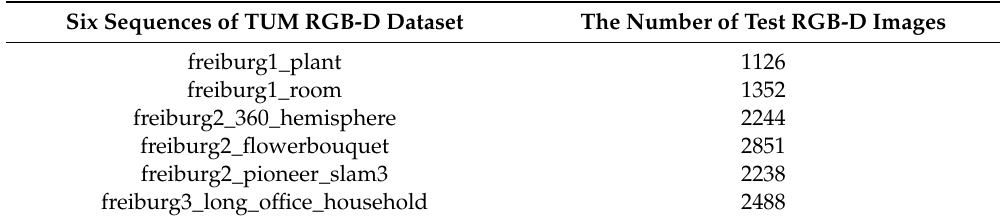
Table 2. The number of test images in each of these six sequences of TUM RGB-D dataset.